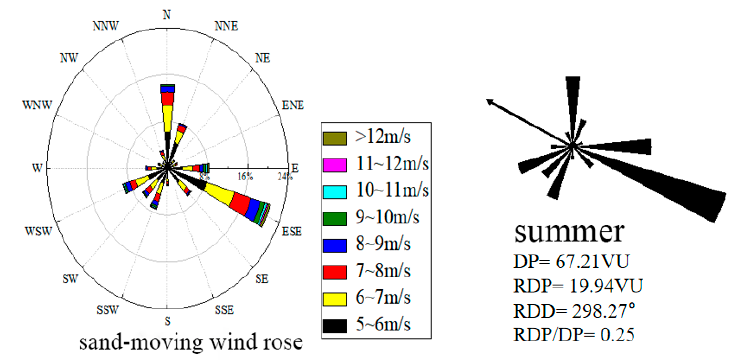
Figure 14. The sand-moving wind rose and drift potential at K166 + 600 of Wuhai–Maqin highway. In order to verify the accuracy of the numerical simulation in actual engineering, the three-dimensional aerial survey of unmanned aerial vehicle was used to photograph and process the sand distribution around the embankment at K166 + 100 in April and August 2021 (Figure 15).